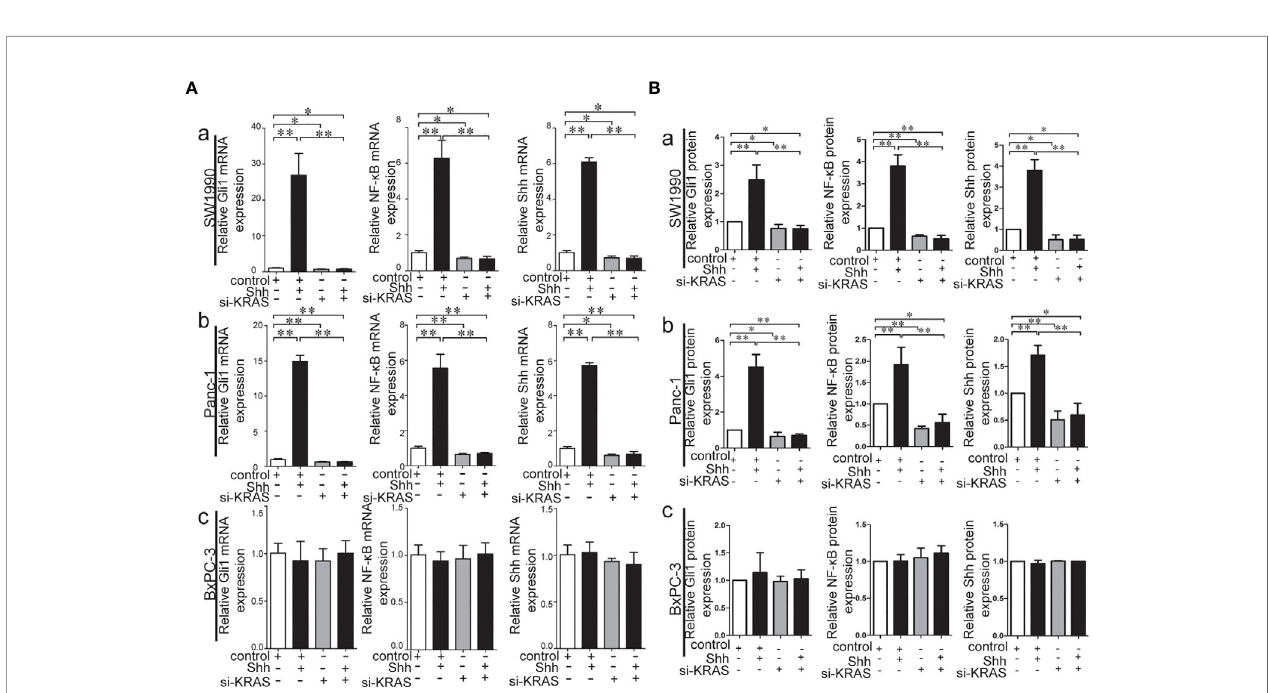
FIGURE 3 | Stimulatory effects on mRNA and protein expression of Gli1, NF- k B and Shh on PDAC cell lines treated with Shh as Hh activating ligand treatment alone or in combination with si-KRAS transfection. (A) mRNA expression of Gli1, NF- k B and Shh in three PDAC cell lines; (B) Gray analysis of relative protein expression [a. SW1990, b. Panc-1, c. BxPC-3]. All data were obtained in three independent experiments. *p < 0.05; **p <